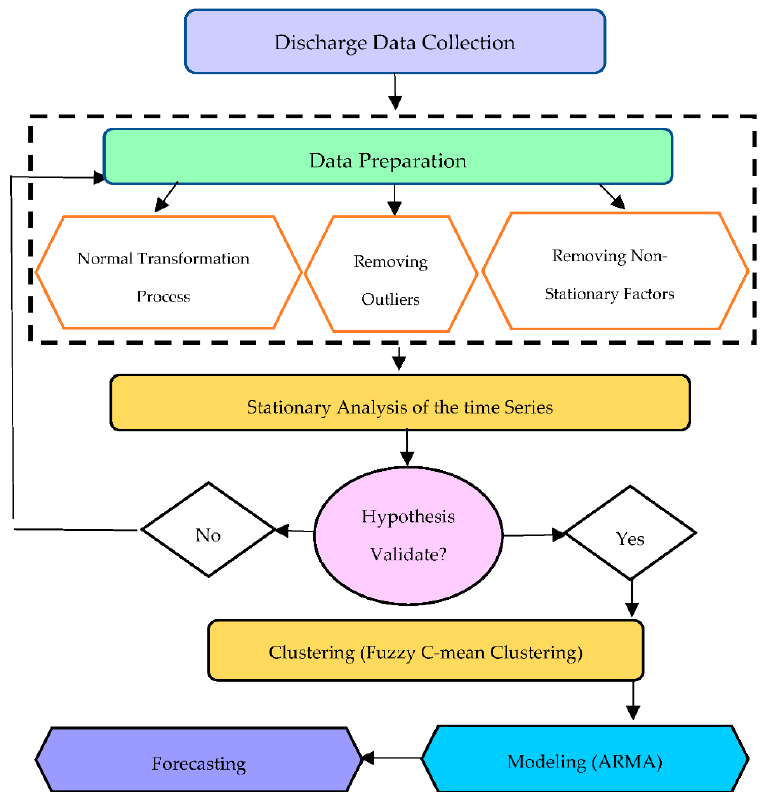
Figure 3. Flow chart showing the used procedure from preparing data to achieving results.